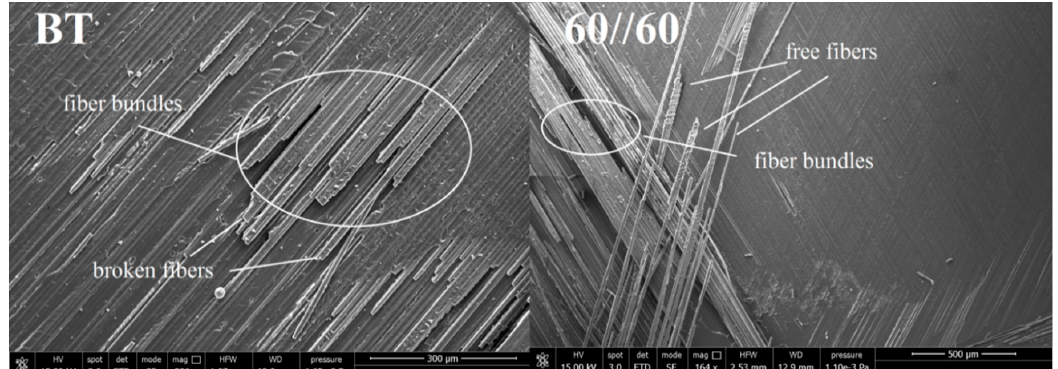
Figure 8. Delamination surfaces after the scanning electron microscope (SEM) investigations for the specimen with 60°//60° delamination interface and for the bending-twisting (BT) laminate.